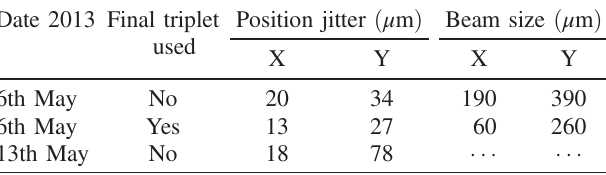
TABLE VIII. Results of beam position jitter measurements on different days along with the predicted beam size at the time of two of the results [23].